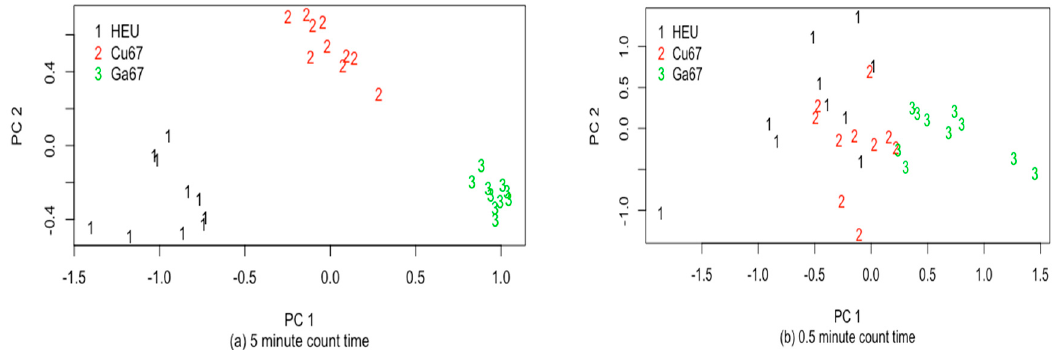
Figure 14. PC 2 versus PC 1 for U-235 (HEU), Cu-67, and Ga-67 for ( a ) 5 min count time without model bias and ( b ) 0.5 min count time with item-specific variation in the model bias.